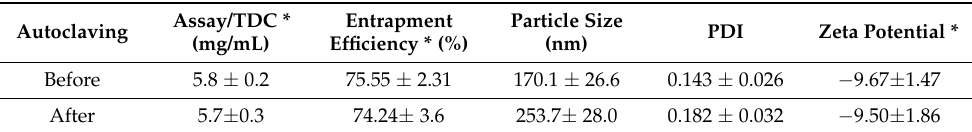
Table 8. Parameters before and after autoclaving ( n =